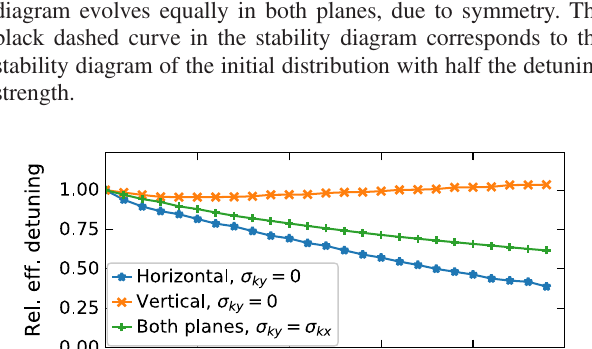
FIG. 5. Evolution with noise in the horizontal plane only: (a) of the distribution; (b), (c) of the stability diagrams in the horizontal and vertical planes, respectively. The black dashed curves in the stability diagrams correspond to the stability diagrams of the initial distribution with half the detuning